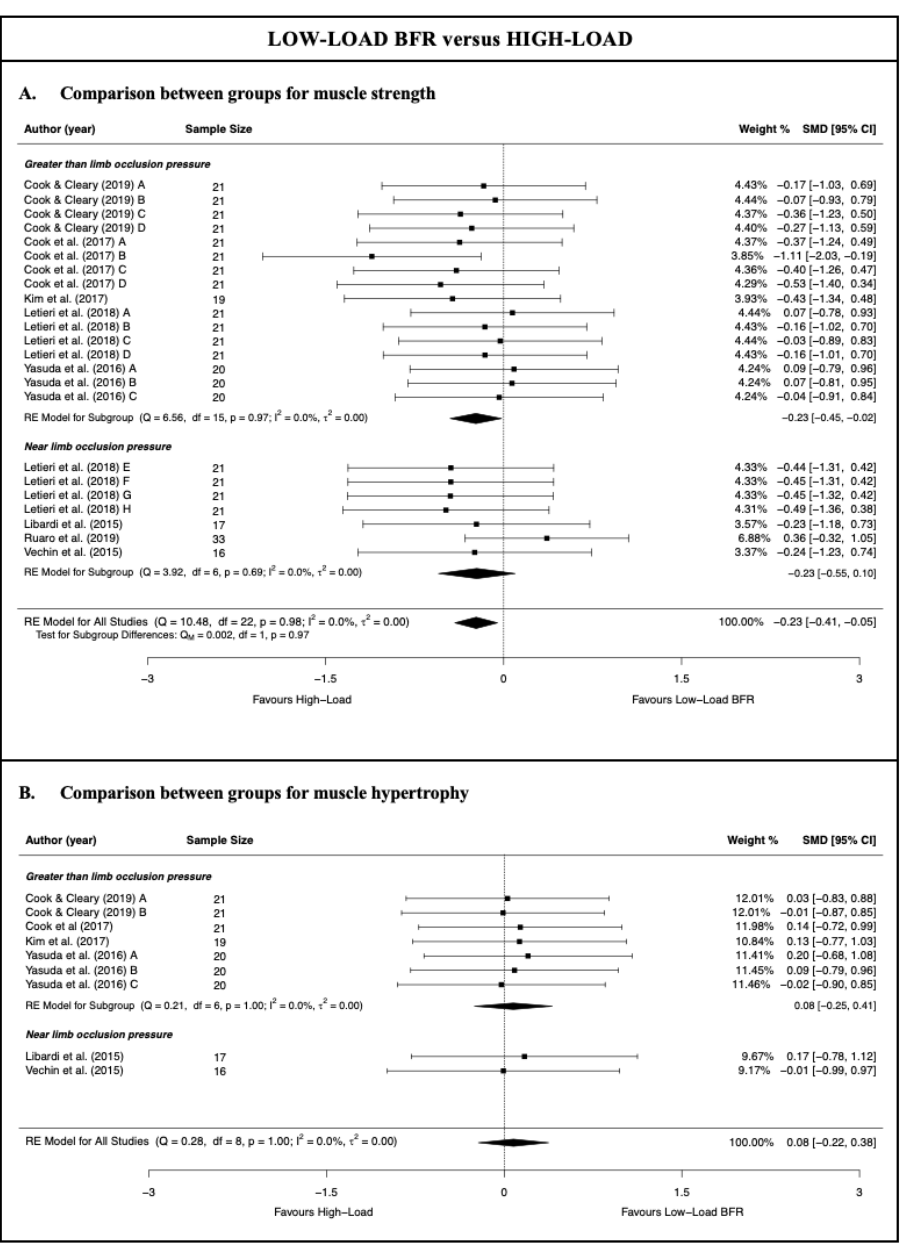
Figure 2. Synthesis forest plot for muscle strength and hypertrophy for low-load blood flow restriction training versus high-load resistance training [28,50 – 56].